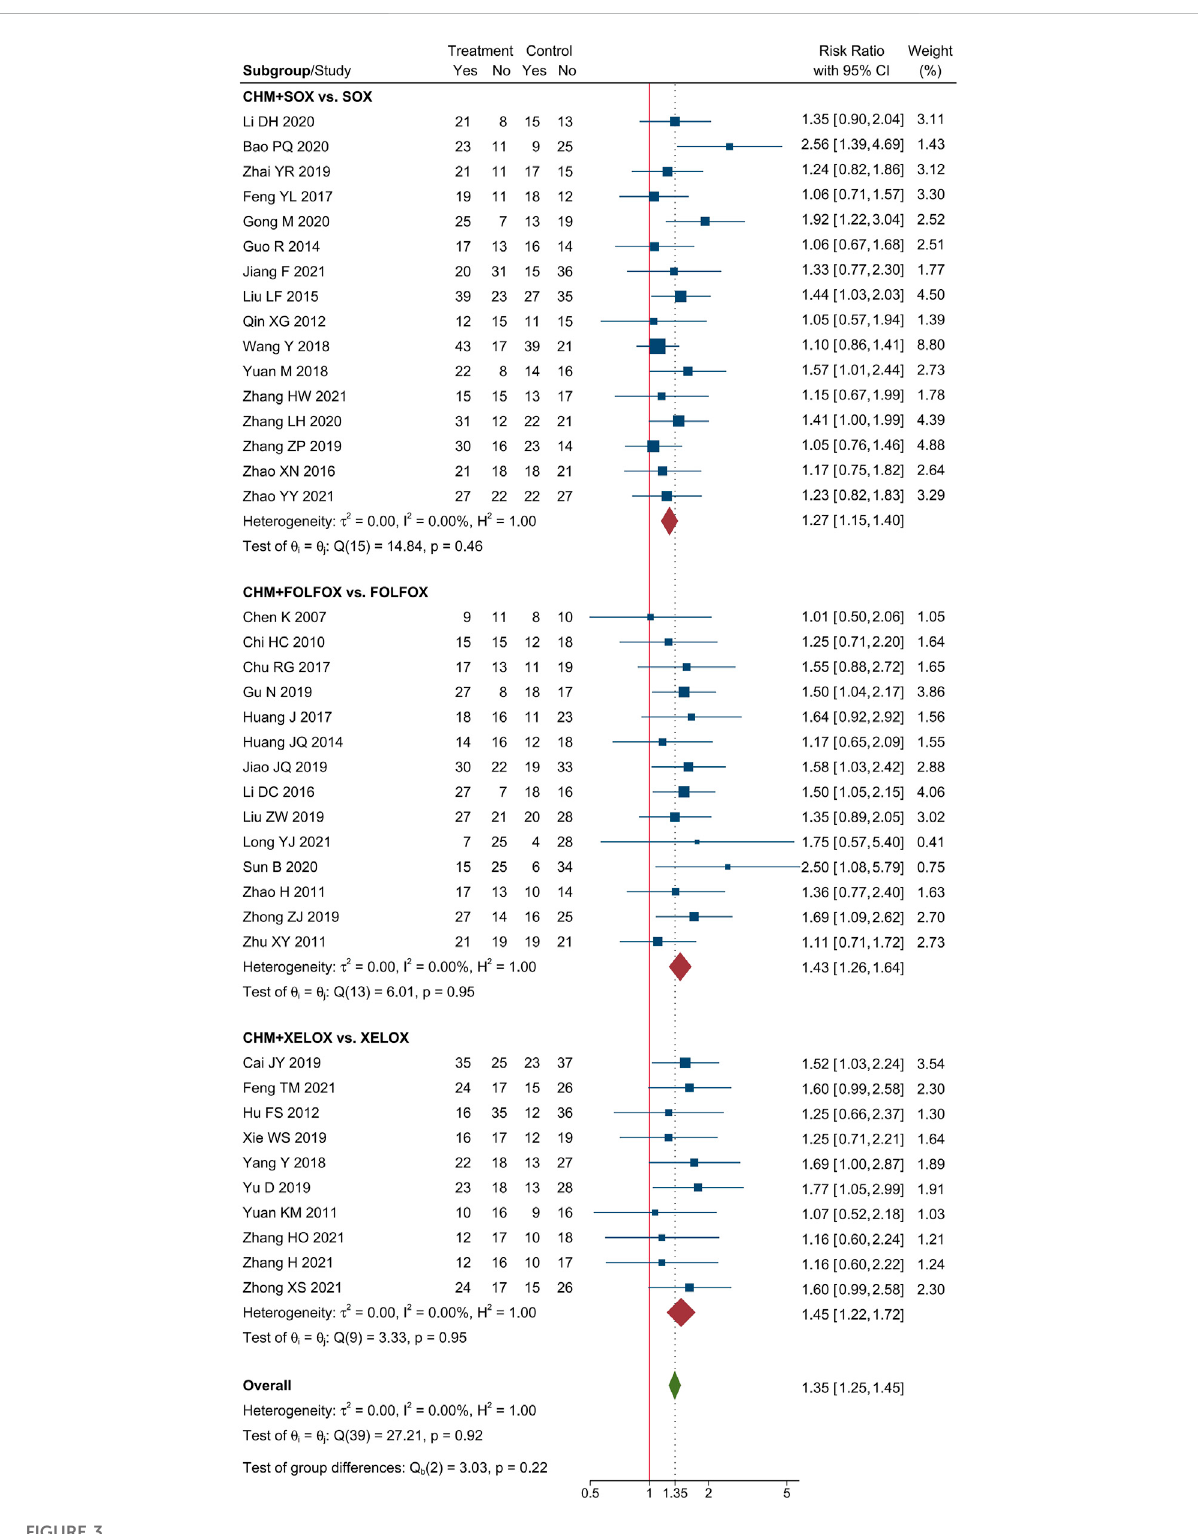
FIGURE 3 Forest plot of